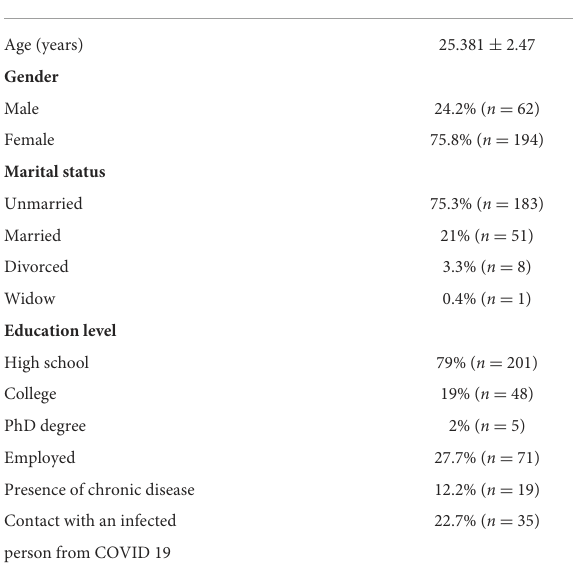
TABLE 1 Demographic characteristics of the